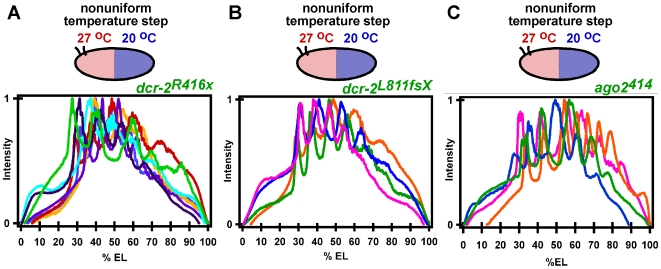
The dcr-2R416x, dcr-2L811fsX, and ago2414 mutations cause enhanced variability in Eve stripe expression and position.(A) Intensity profile of Eve expression as a function of embryo length in seven dcr-2R416x embryos exposed to a temperature step. (B) Intensity profile of Eve expression as a function of embryo length in four dcr-2L811fsX mutant embryos exposed to a temperature step. (C) Intensity profile of Eve expression as a function of embryo length in four ago2414 embryos exposed to a temperature step.